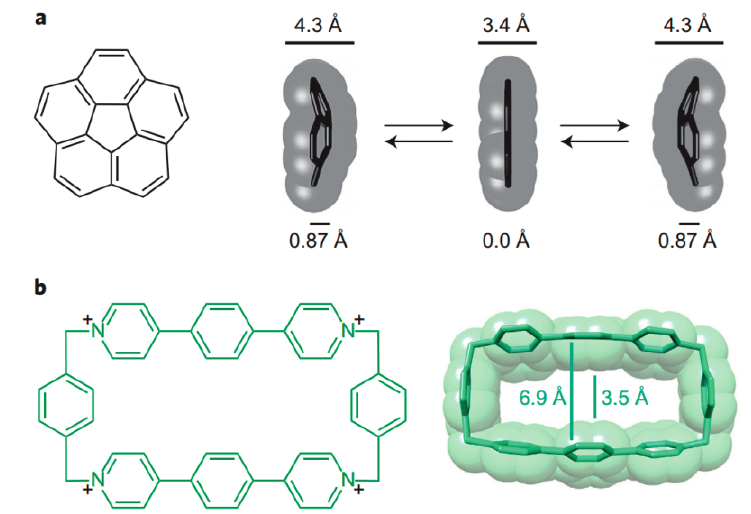
Figure 20. Corannulene ( a ) fits to a tetracationic cyclophane host ( b ) only in the flat transition state structure of the substrate, not its ground state, leading to faster inversion of the corannulene [114]. Reprinted from ref. [114] with permission from Nature Publishing